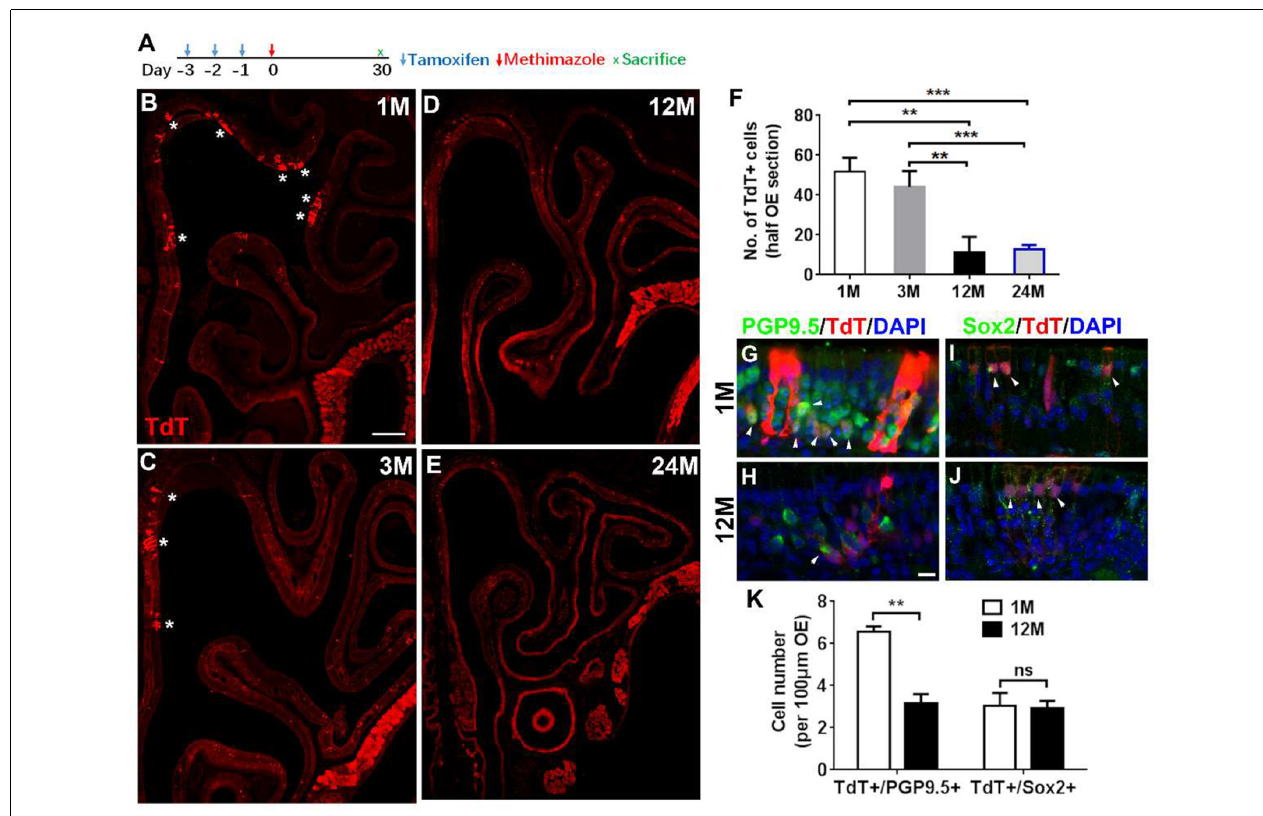
FIGURE 5 | Aging reduced the progenies of Lgr5+ cells in injured OE. (A) Scheme showing the lineage tracing of Lgr5+ cells in Lgr5-CreERT2/Rosa26-TdTomato (LT) mice. (B–E) Confocal images of lineage-traced TdT+ cells in the OE of LT mice at 1-, 3-, 12-, and 24-month old at Day 30 postinjury. *In (B) and (C) denoted TdT+ cell bundles. (F) Statistical analysis of TdT+ cell density in the OE at Day 30 postinjury. Totally, 2, 525, 921, 766, and 289 TdT+ cells were counted in mice at 1-, 3-, 12-, and 24-month old ( n = 3). (G,H) Immunostaining against PGP9.5 in the OE of 1- and 12-month-old LT mice at Day 30. TdT+/PGP9.5+ cells were noted by arrowheads in (G,H) . (I,J) Confocal images of TdT+/Sox2+ cells (arrowheads labeled) in the OE of 1- and 12-month-old LT mice at Day 30. (K) Statistical analysis on the density of TdT+/PGP9.5+ and TdT+/Sox2+ cells in LT mice at 1- and 12-month old. Statistical significance was determined by unpaired t -test. ns, not significant. In (F) and (K) , ** p < 0.01, *** p < 0.001. Scale bars: 0.2 mm in (B) and 20 µ m in (H)